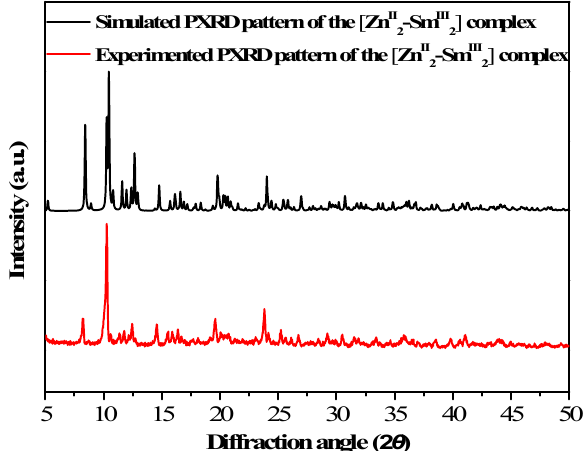
Figure 1. Comparison of the simulated and experimental powder X-ray diffraction (PXRD) patterns of the [Zn II2 –Sm III2 ] complex.